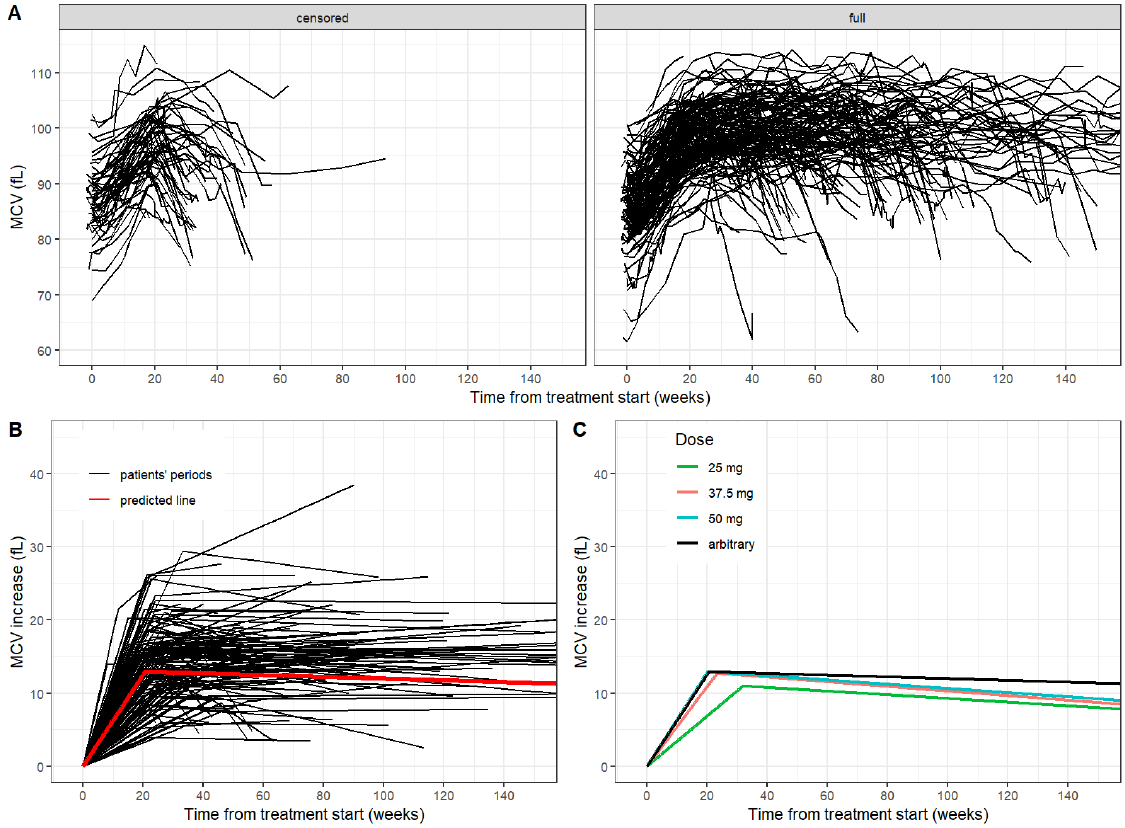
Figure 2. ( A ) Time-courses of the MCV according to censored and full period groups. ( B ) Fit regression models with broken-line relationships for patient periods in full period groups (black) and common predicted line (red). ( C ) Dose-related predicted lines for the full period group.